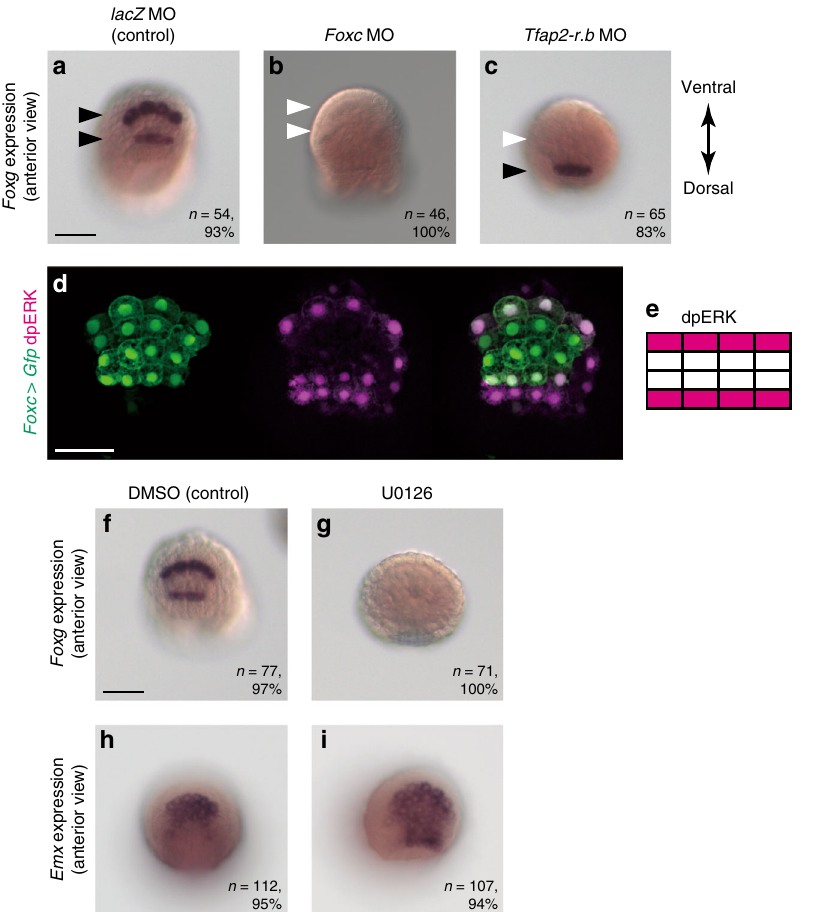
Fig. 7 Upstream mechanism that regulates speci fi c expression of Foxg . a – c Foxg expression in embryos injected with a the lacZ control MO, b the Foxc MO, and c the Tfap2-r.b MO. Rows that express Foxg are shown by black arrowheads, and rows that lose the expression are shown by white arrowheads. d Immunostaining of dpERK (magenta) in an embryo in which ANB cells were marked with Foxc > Gfp . The brightness and contrast of fl uorescence images were adjusted linearly. Note that dpERK signals are also seen in the most anterior row of the neural plate. e Depiction of dpERK-positive cells in the ANB. f – i In situ hybridization of f , g Foxg and h , i Emx in f , h control embryos and g , i embryos treated with U0126. The number of embryos examined and the proportion of embryos that each panel represents are shown within the panels. The scale bar in ( a ) represents 50 μ